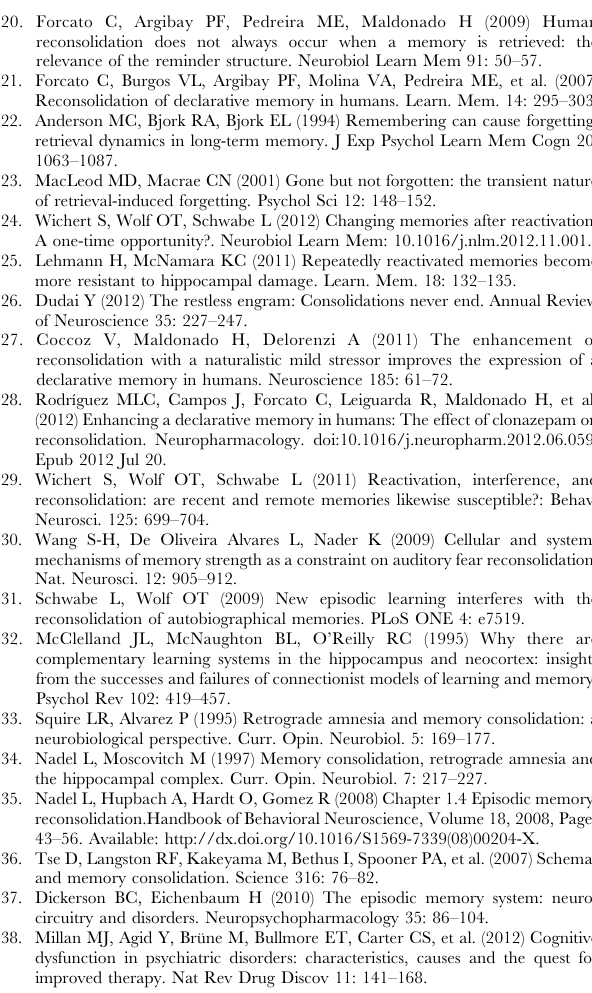
Figure S4 Learning curves. Mean number of errors + / 2 SEM per trial on Day 1. On the first trial the List is presented for the first time. G) Experiment 3.B. List 1 Training. Black rombhus stands for the Group NR 8d and gray squares for the Group RcX1-L2. Inset . Mean number of total errors in the four last actual trials. Black bar stands for Group NR 8d and gray bar for the Group RcX1-L2. H) Experiment S2. Black rombhus stands for the Group NR 3d and White squares for the Group NR 8d. Inset . Mean number of total errors in the four last actual trials. Black bar stands the Group NR 3d and White Squire for the Group NR 8d. (TIF) Text S1 Description of Experiment S1: Retrieval does not modify memory